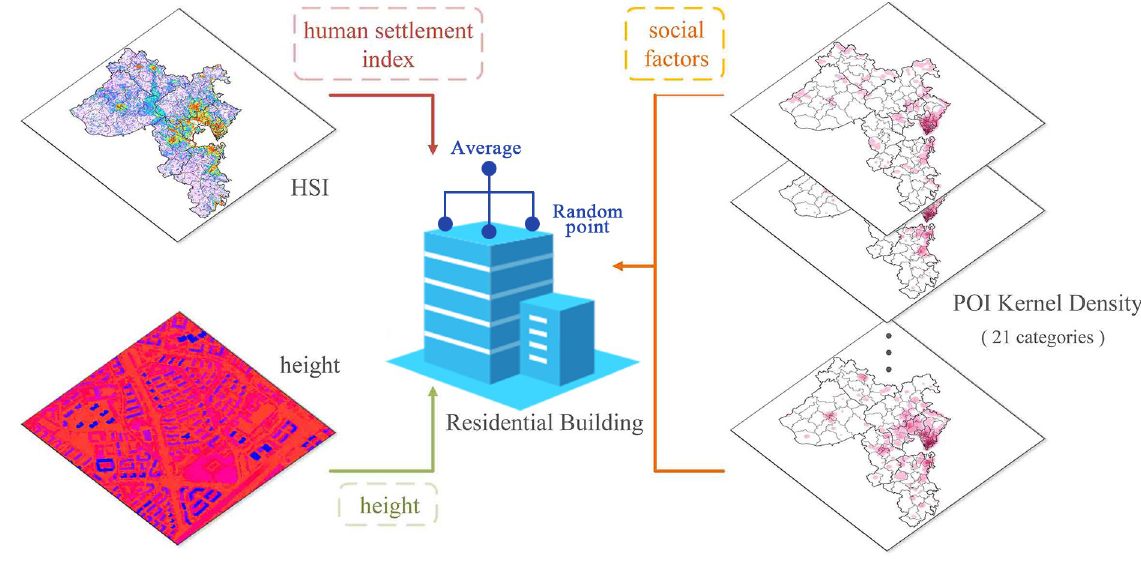
Fig 4. Attribute mapping of residential